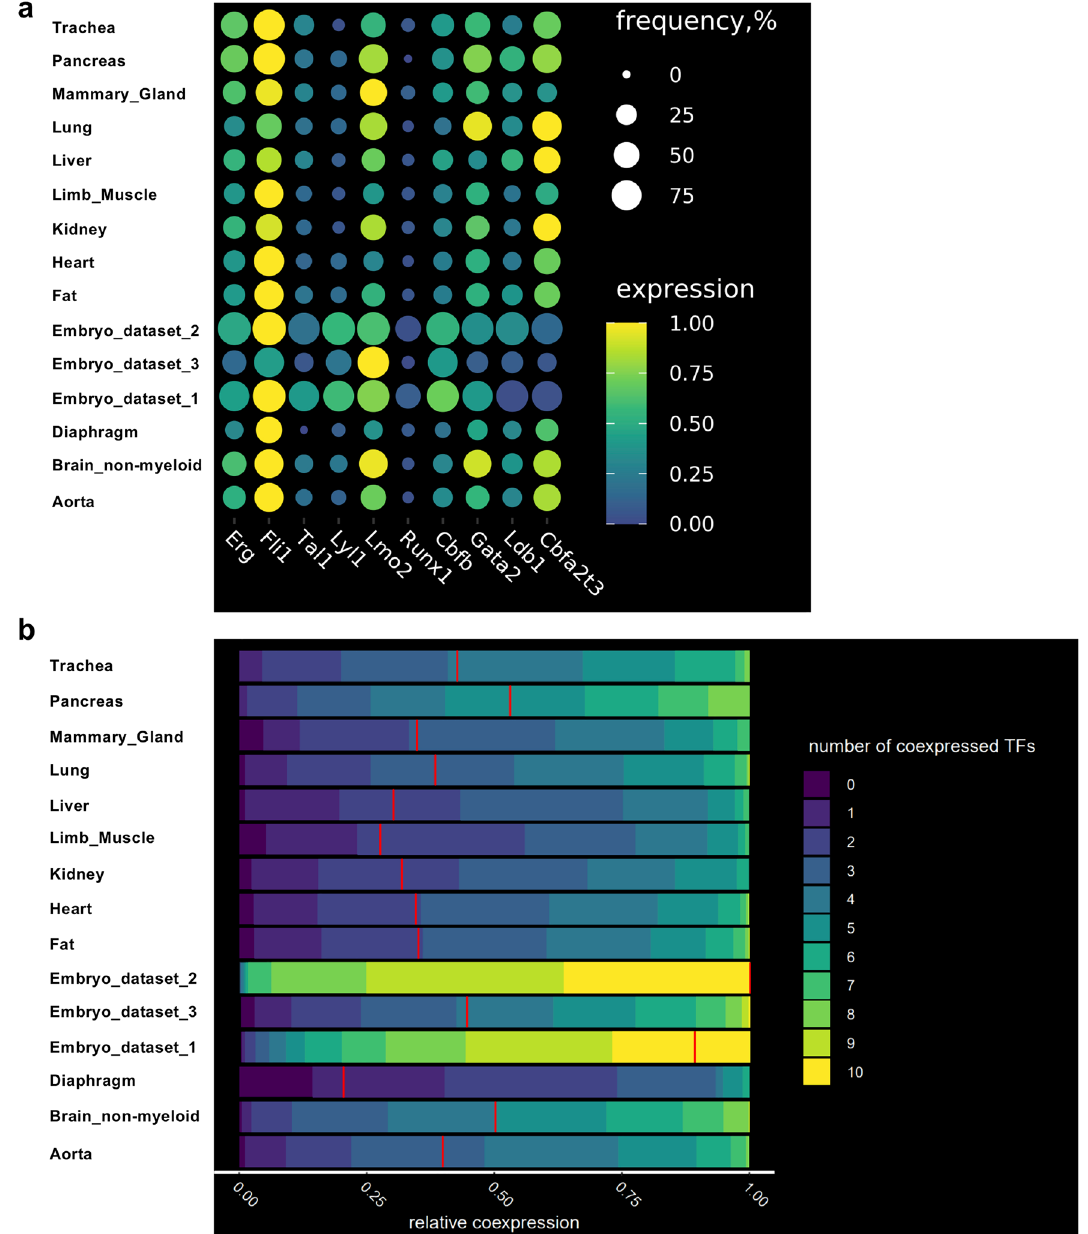
Figure 3. The frequency of cells co-expressing key transcription factors at the single-cell level is lower in adult endothelial cells compared to embryonic ones. ( a ) Dot plots showing the frequency and level of expression of the indicated transcription factor coding genes in embryonic and adult endothelial cells; ( b ) Heatmap showing the relative co-expression of the indicated transcription factor coding genes in embryonic and adult endothelial